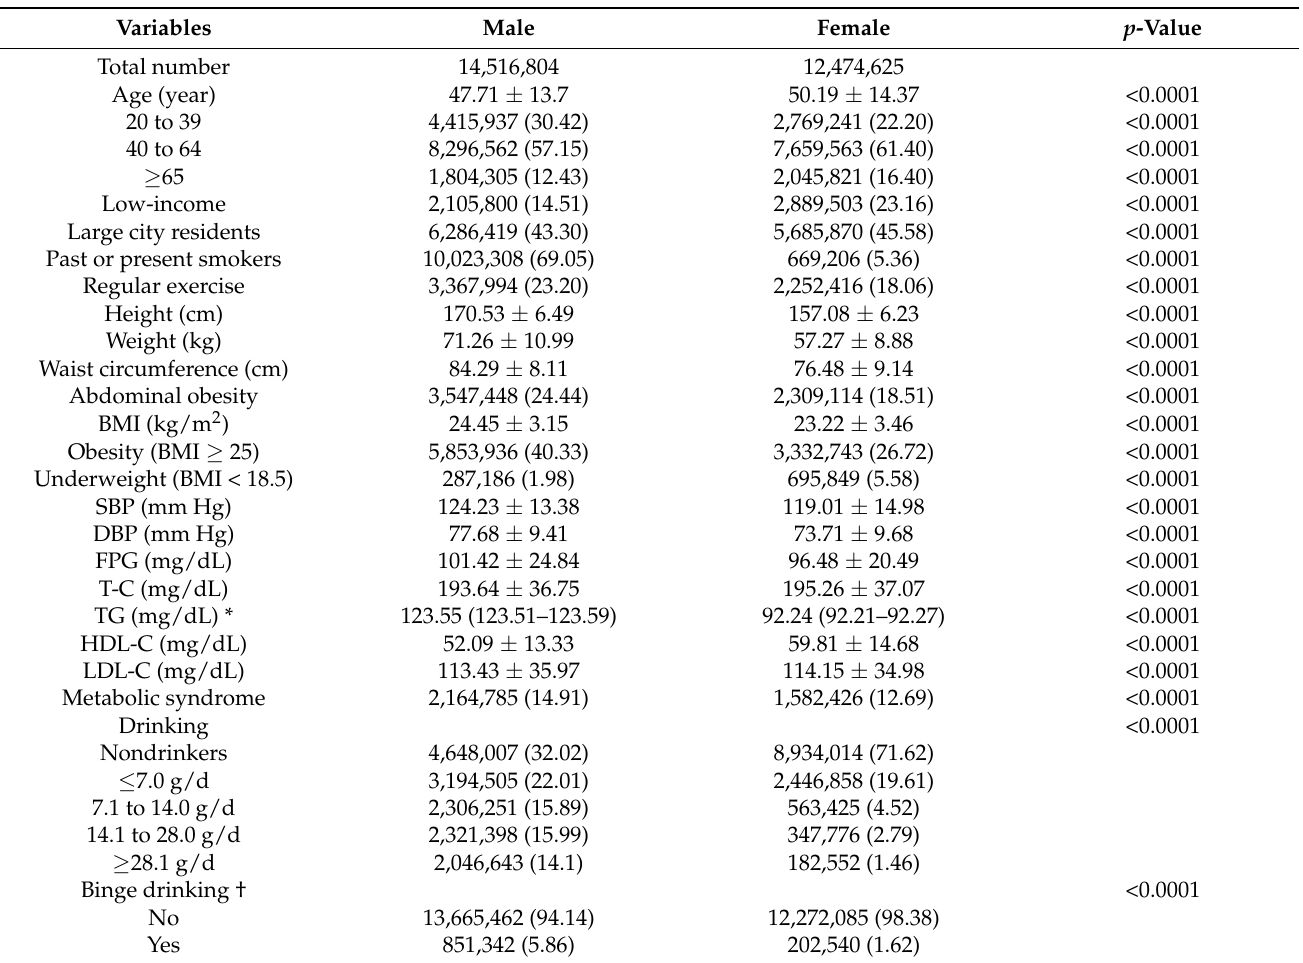
Table 1. Baseline characteristics of the